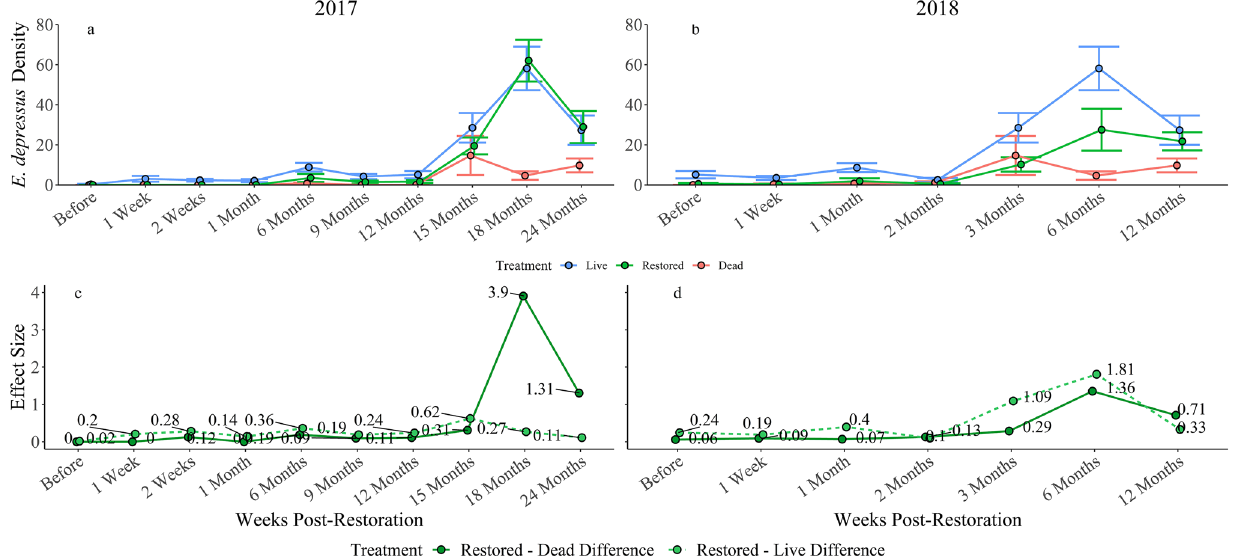
Figure 6. Density and effect size of treatment Eurypanopeus depresses over time. Abundance increased as soon as 6-months post-restoration. Abundance recovered fully after approximately 18 months after restoration. The effect of treatment on the difference between restored and dead reefs was low early in the study. However, the effect size increased over time. At the same time, the effect of treatment on the differences between restored and live reefs was small during this